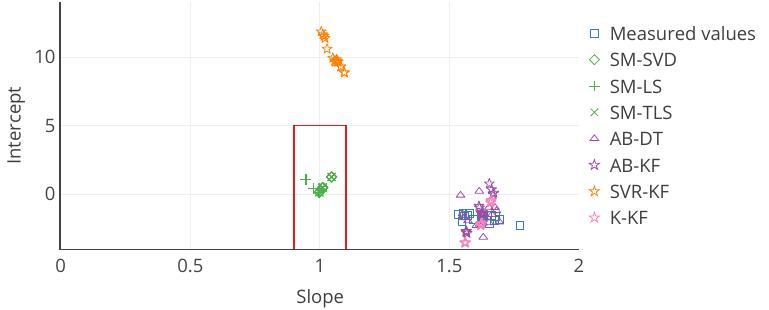
Figure 11. Target plot of the 16 nodes as a function of their slope and intercept in the error model for each calibration strategy. The slope and intercept are computed on the entire time interval of drift. In this case, it allows to locate an instrument according to the slope and intercept of its associated error model. The red rectangle is an example of area that can be defined to quickly identify instruments that are not satisfying a requirement, here a slope in [ 0.9;1.1 ] and an intercept in [ − 5;5 ]